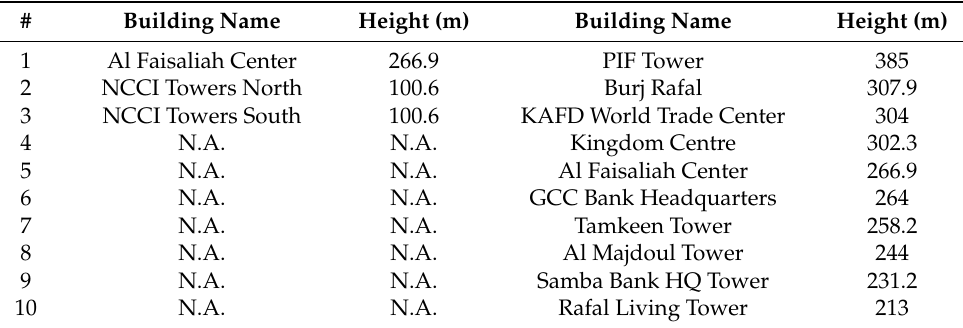
Figure 17. Riyadh in 2000 and 2020. Table 27. Riyadh’s 10 tallest skyscrapers in 2000 and 2020.